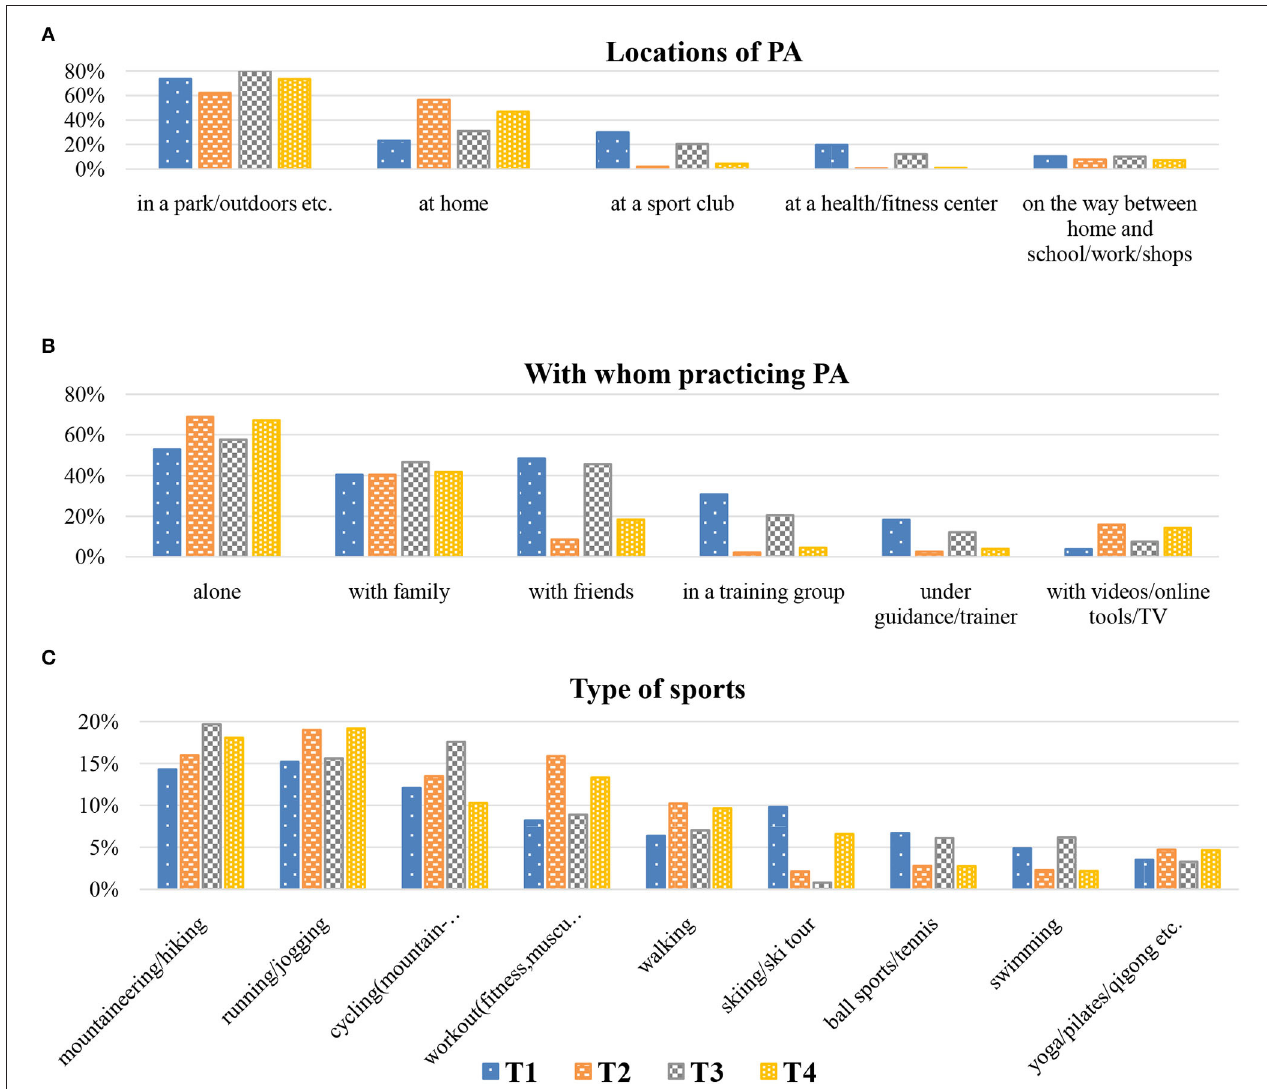
FIGURE 2 | (A) Locations of PA, (B) with whom participants practiced PA and (C) type of sports, over four time periods (T1–T4) for the total sample.